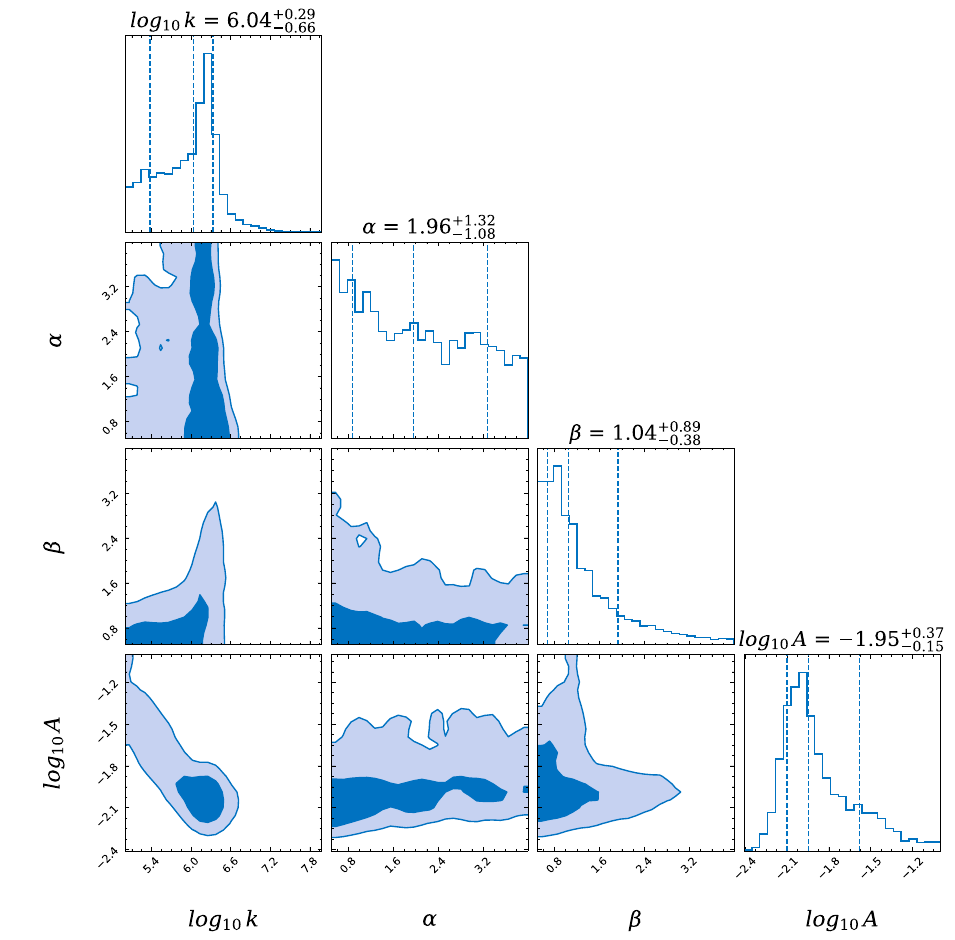
Fig. 6 The posteriors on the parameters in parameterization (32) from the first five frequency bins of NANOGrav 12.5 years data set, and the shaded areas denote 1 σ and 2 σ confidence